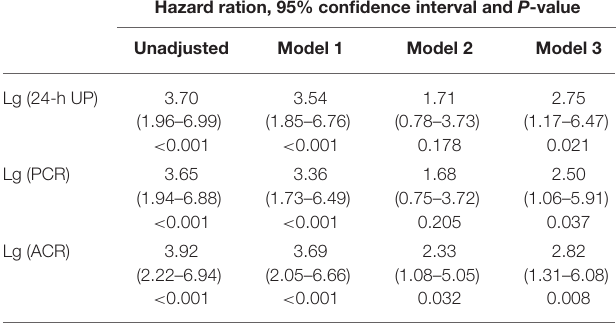
TABLE 3 | Association of 24-h urinary protein excretion and PCR with composite kidney disease progression. Hazard ration, 95% confidence interval and P